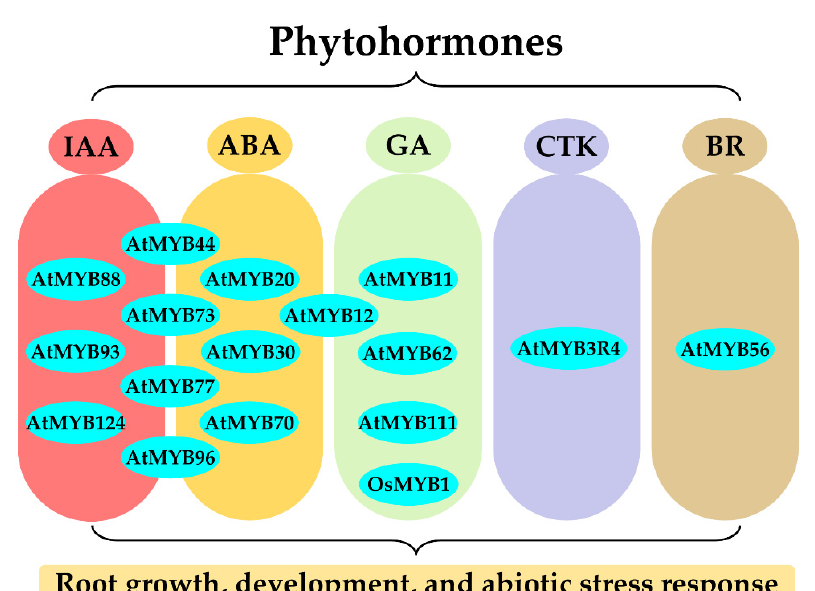
Figure 3. The regulatory roles of MYBs in roots are mediated by various phytohormones. IAA: indole acetic acid; ABA: abscisic acid; GA: gibberellin; CTK: cytokinin; BR: brassinosteroid. The blue dots represent MYB TFs. The MYBs crosslink different types of phytohormones indicating they can integrate different phytohormone signaling.